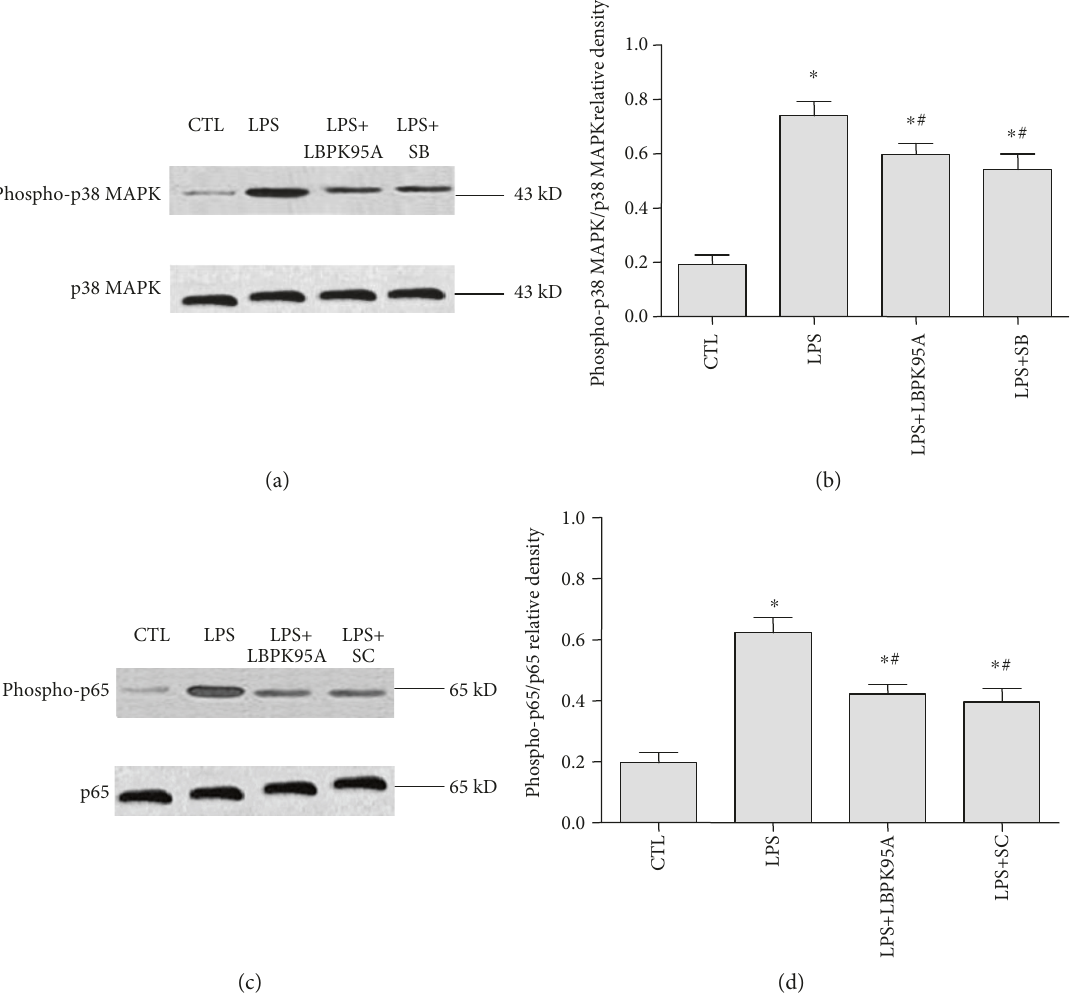
Figure 8: Expression of phospho-p38 MAPK and phospho-p65 in lung tissue homogenates from rats with ARDS. Western blotting was used to detect the expression of phospho-p38 MAPK and phospho-p65 in the ARDS rat model with and without inhibitors following LPS treatment. LBPK95A, SB203580, and SC-514 inhibited the LPS-induced expression of phospho-p38 MAPK (a) and phospho-p65 (b) as seen from the relative densities of phospho-p38 MAPK/ β -actin (c) and phospho-p65/ β -actin (d). ∗ represents p < 0 05 when compared with that in the control rats; # represents p < 0 05 when compared with that in the LPS-induced rats. △ represents p < 0 05 when compared with that in the LPS+LBPK95A